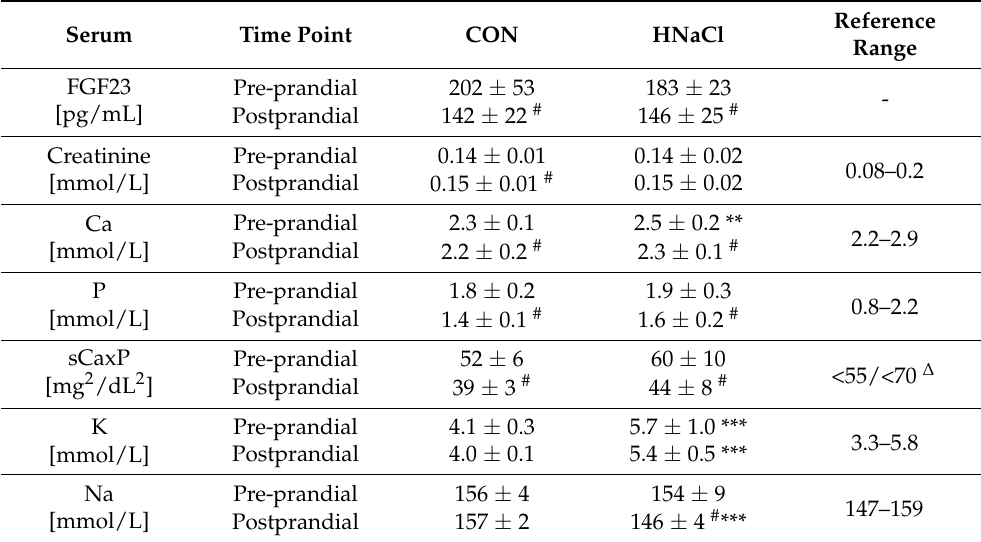
Table 3. Concentrations of serum parameters after 28 days of high NaCl or control feeding in cats (mean ± standard deviation).